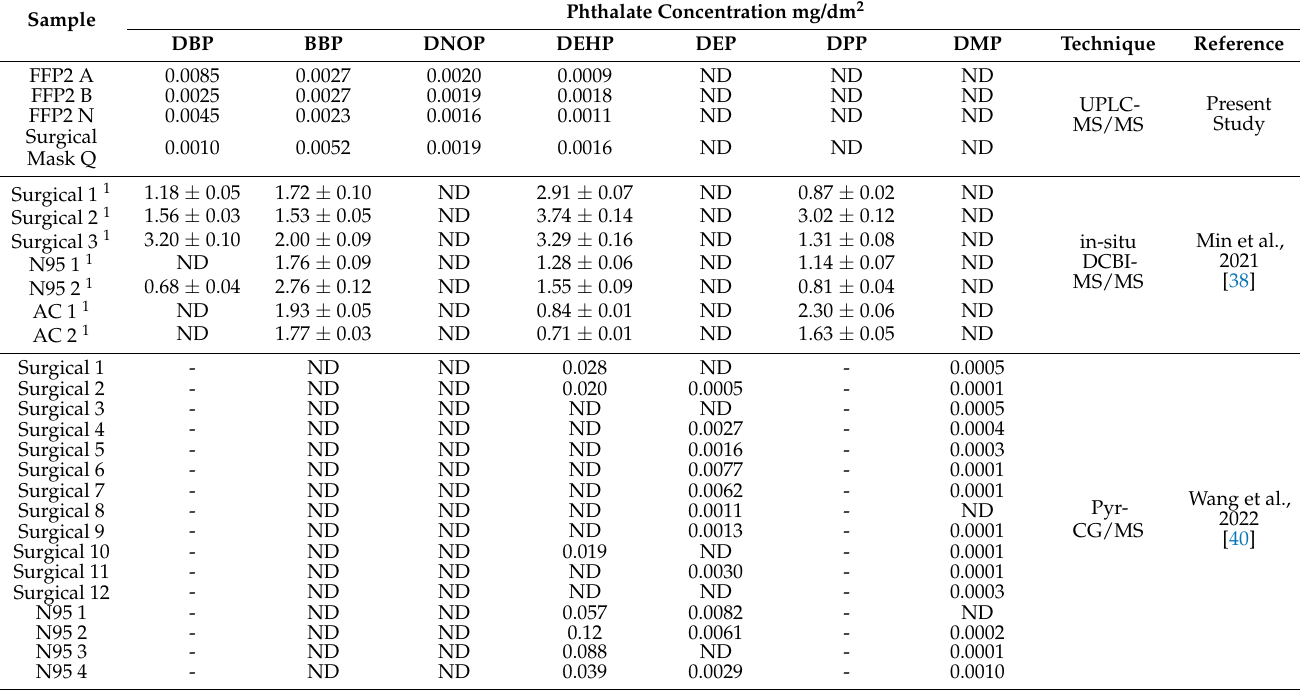
Table 6. Phthalate concentration in the present study and comparison with other studies on surgical, N95 or activated charcoal (AC) masks in mg/dm 2 . ND = Not Detected; - = phthalate not included in the study. The blank contribution has been already subtracted from the phthalate